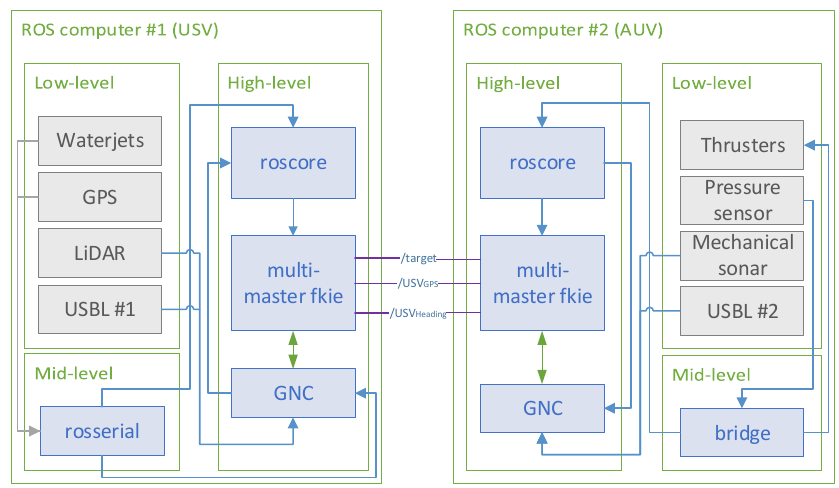
Figure 12. Communication of the autonomous offshore system based on the multimaster-fkie architecture. Each vehicle shows the internal connection between the sensors and actuators with the rest of the